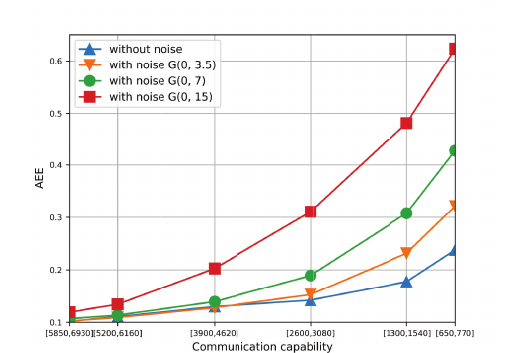
Figure 14. The AEE of the proposed algorithm under different magnitudes of additive